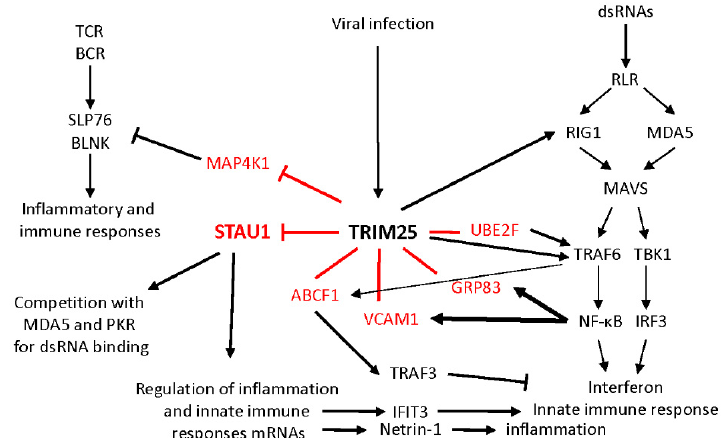
Figure 7. A family of proteins linked by the FPL-motif is involved in inflammation. Schematic representation of the interactions between proteins of the FPL-motif family, the E3 ubiquitin ligase TRIM25, and proteins of the adaptive (left pathway) and innate (right pathway) immune response pathways. TRIM25 activates the RIG1 pathway of the innate immune response via K63-ubiquitination of RIG1 and TRAF6. On the other hand, TRIM25 causes the degradation of MAP4K1, an inhibitor of the adaptive immune response via the T-cell (TCR) and B-cell (BCR) receptor pathways. It also degrades STAU1 55 . Through competition for dsRNA binding, STAU1 55 prevents the activation of proteins of the innate immune response, such as MDA5 and PKR. STAU1 55 also up- or downregulates the expression of multiple mRNAs coding for proteins of the inflammatory and immune response pathways. For example, the STAU1 55 -mediated upregulation of IFIT3 and netrin-1 leads to enhanced immune response via the activation of the MAVS pathway and inflammation, respectively. TRIM25 also targets other proteins (in red). Whether it activates (K63-ubi) or degrades (K48-ubi) these proteins is still unresolved. UBE2F activates the NF- κ B pathway and interferon production by K63-ubiquitination of TRAF6. ABCF1 enhances anti-inflammatory response by K63-ubiquitination-mediated activation of TRAF3. In turn, NF- κ B binds the promotor of the VCAM1 and GRP83 genes and upregulates their expression.